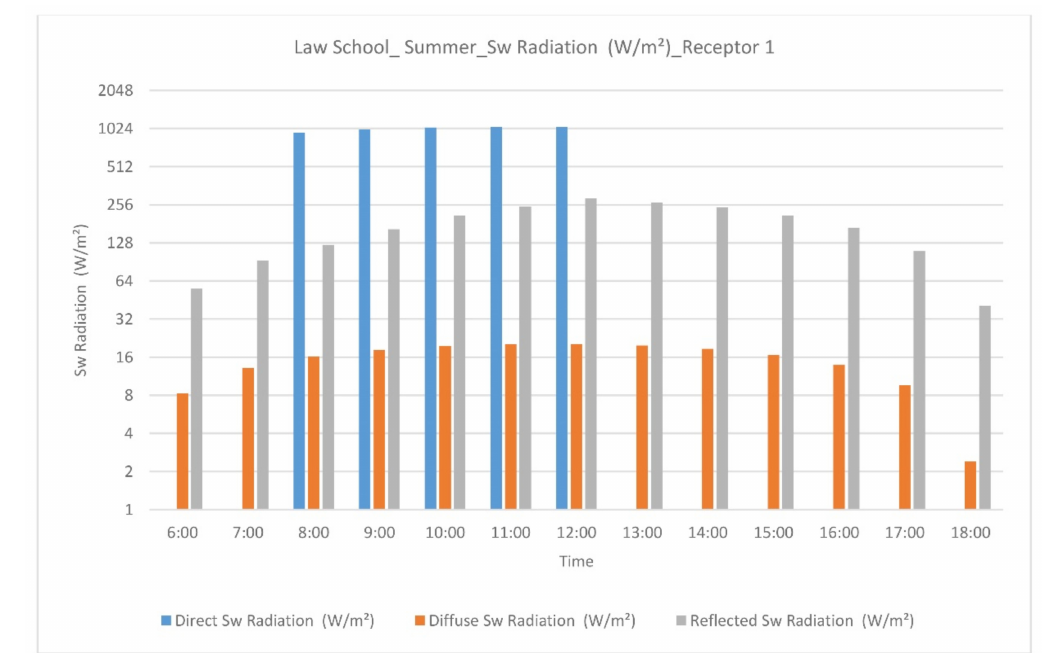
Figure A5. Open space 2 solar radiation in summer at receptor 1.